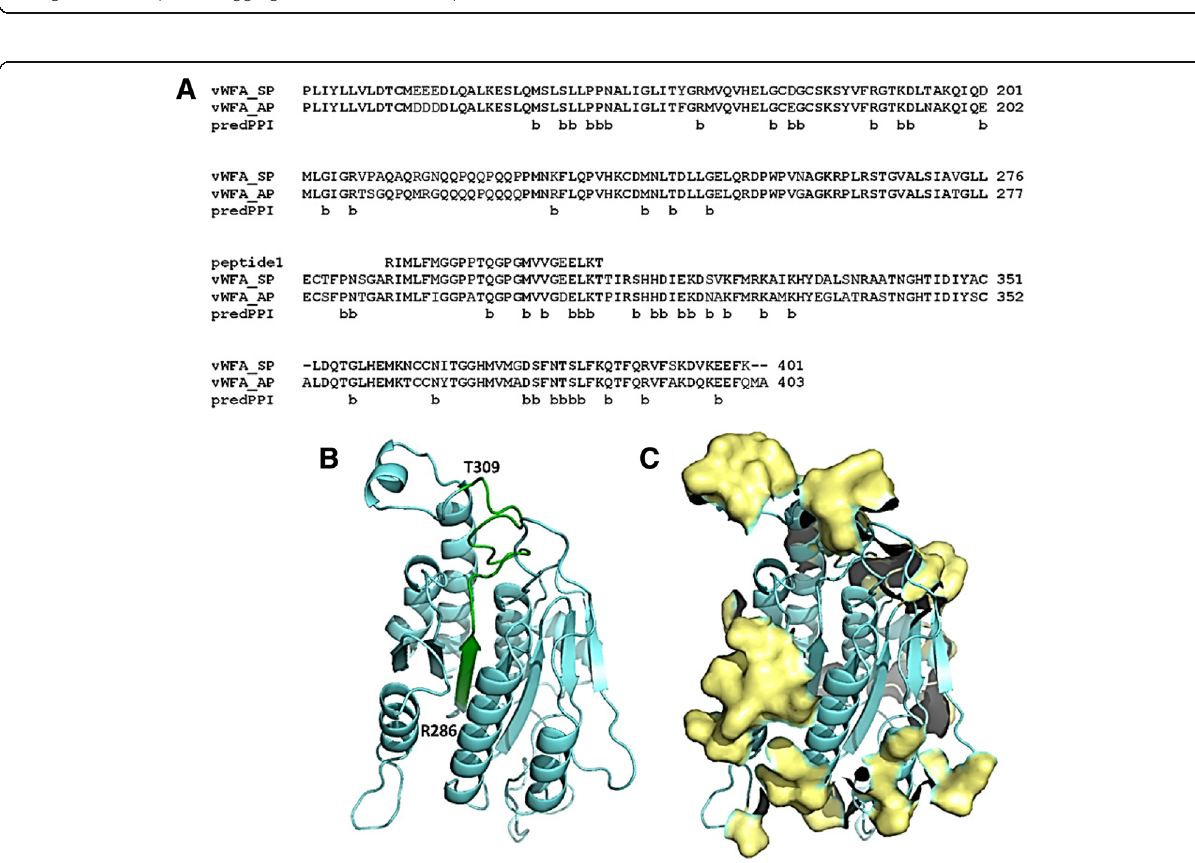
Fig. 9 vWFA-like domain from the organism Strongylocentrotus purpuratus and its putative functional sites. A Multiple sequence alignment of “ peptide1 ” and vWFA-like domain from the organisms Strongylocentrotus purpuratus (vWFA_SP; NCBI RefSeq accession numbers XP_780042.1) and Acanthaster planci (vWFA_AP; NCBI RefSeq accession numbers XP_022096018.1). The alignment was generated using CLUSTAL Omega version 1.2.4 ( /www.ebi.ac.uk/Tools/msa/clustalo/ ). Predicted solvent accessible protein – protein interacting residues (predPPI) are highlighted ( “ b ” ). Solvent accessibility and PPI residues were predicted using NetSurfP (version 1.1, http://www.cbs.dtu.dk/services/NetSurfP/) and LORIS (Dhole, Singh, Pai, & Mondal, 2014), respectively. B Ribbon representation of the modeled vWFA_SP (5kyn_A as template with sequence identity 77.5%) generated using SwissModel (Bienert et al., 2017). Highlighted position (green, R286 to T309) on this model is identical with “ peptide1. ” C Predicted solvent accessible PPIs (predPPI) mapped on the modeled vWFA_SP. Figure B and C were generated using PyMol (version